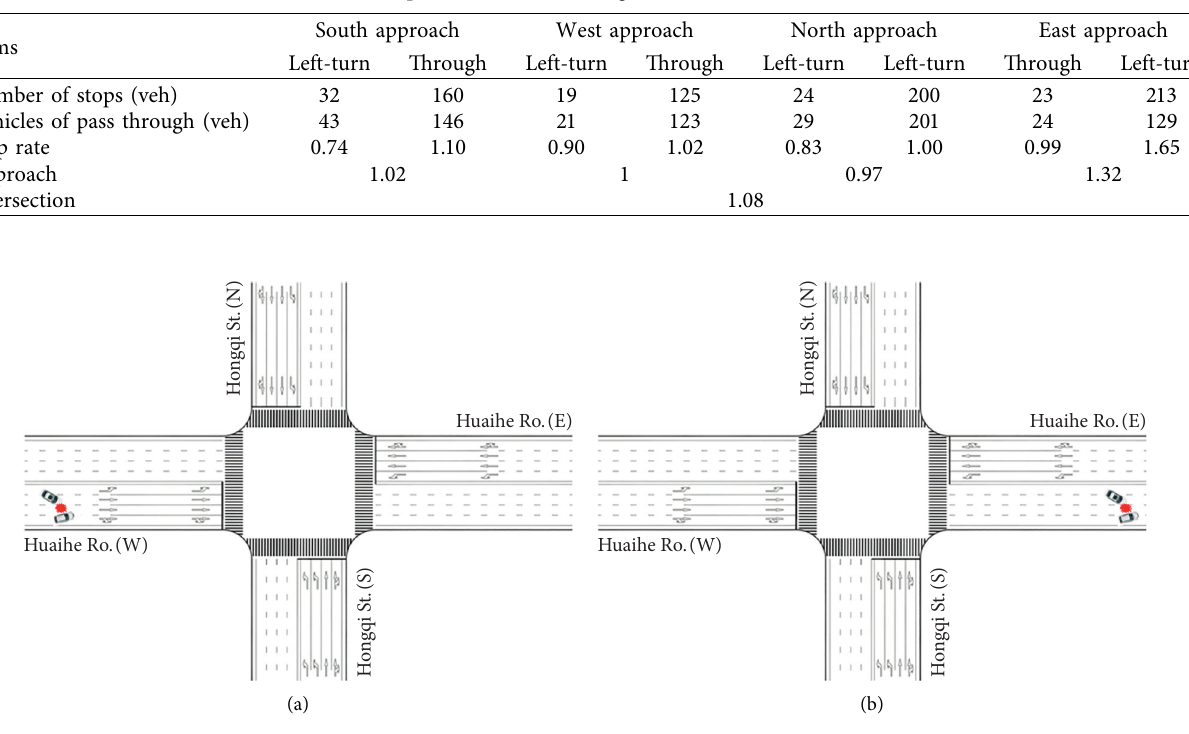
Table 5: Simulation stop rate of the current signal control scheme at the intersection.